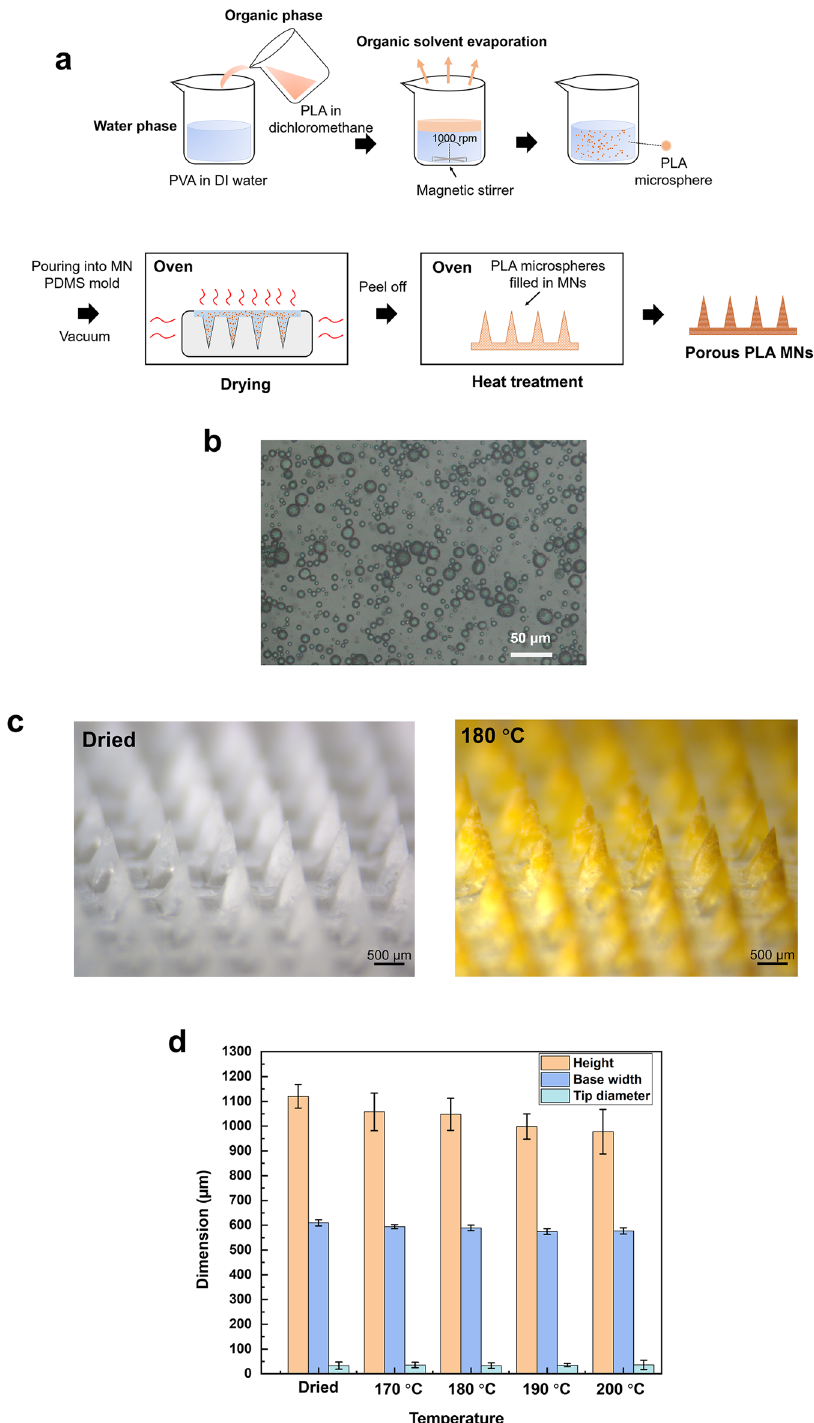
Figure 2. Fabrication of porous PLA MNs with emulsion droplets. ( a ) Single emulsion was used for fabricating PLA microspheres followed by heat treatment for melting and bonding microspheres to form interconnected micropores. ( b ) Fabricated PLA microspheres imaged by optical microscopy. ( c ) Porous PLA MN array before (left) and after treatment (right) at 180 °C for 30 min. ( d ) Dimensions of porous PLA MNs after heat treatment (n =